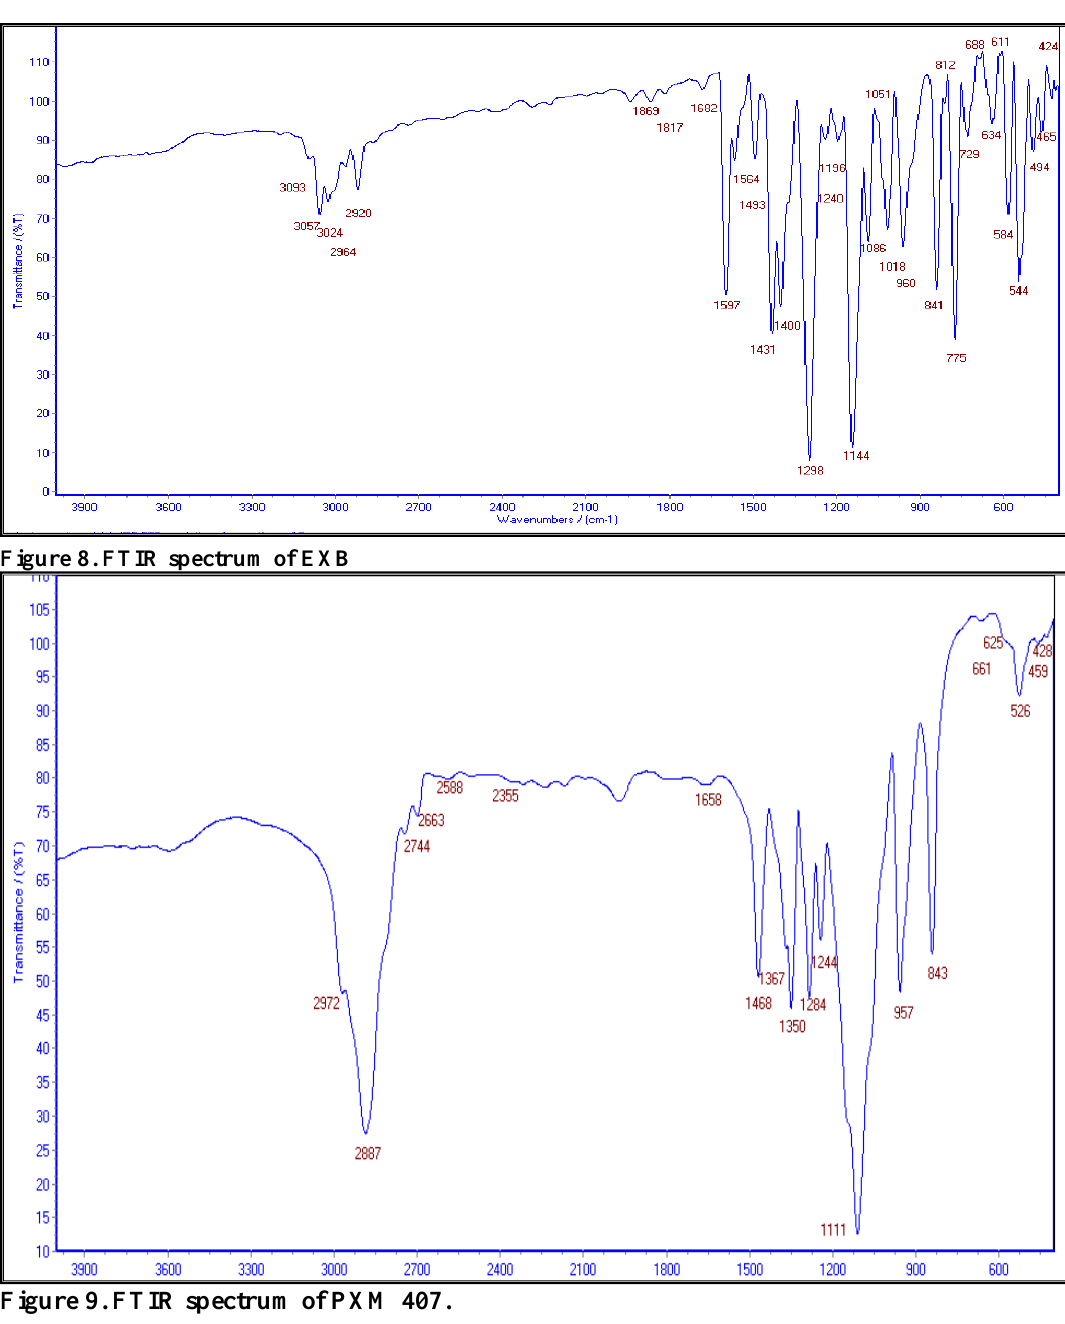
Figure 9. FTIR spectrum of PXM